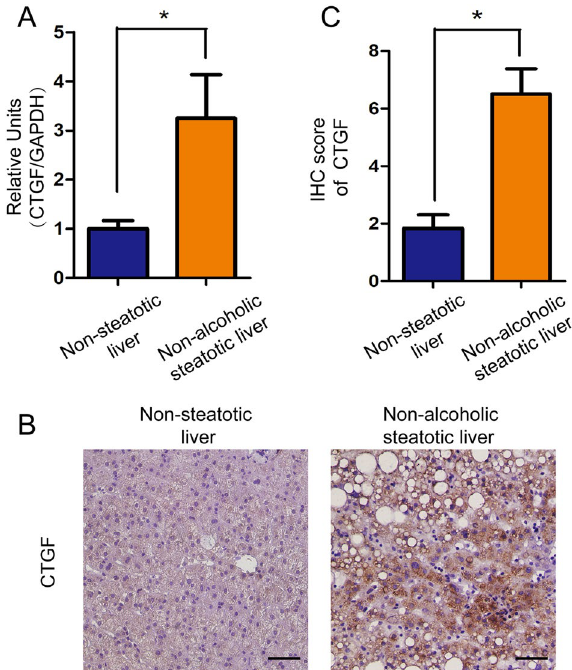
non-alcoholic steatotic liver after brain death as determined by RT-qPCR (* P < 0.05). ( B ) Expression of CTGF in the non-steatotic liver and in the non-alcoholic steatotic liver after brain death by IHC (Scale bar = 20 μm,